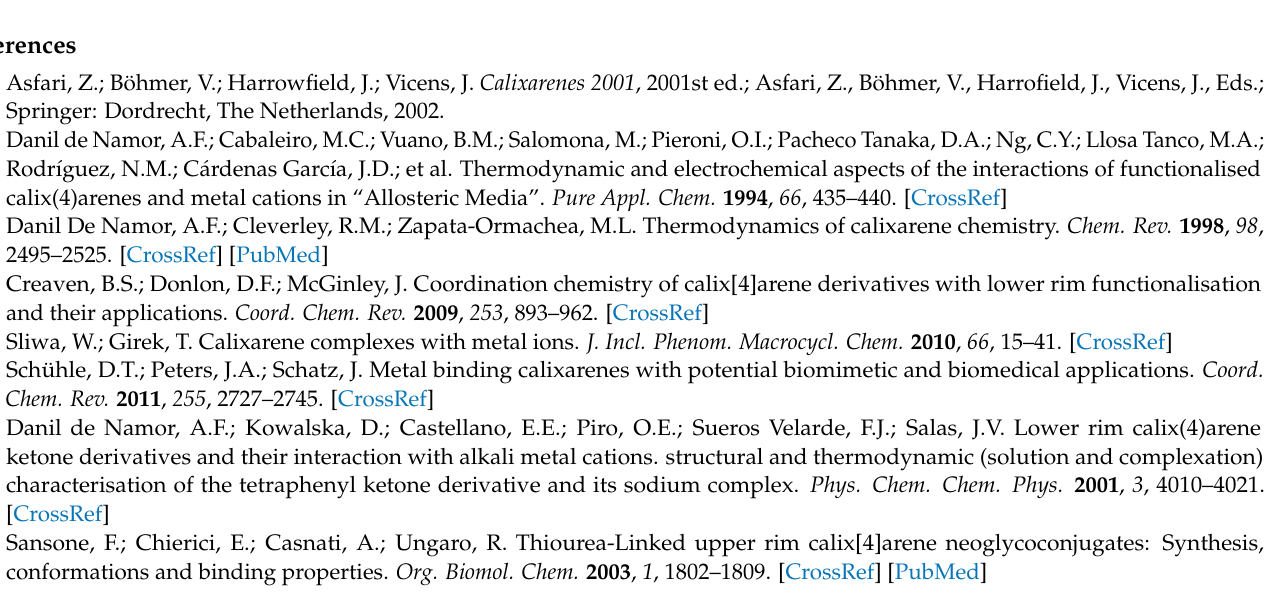
Figure S55, Molecular dynamics simulations: graphical summation of the results obtained for alkali metal complexes with glycocalixarene l. Figure S56, Time-averaged percentage and number of cation- coordinating groups of l in MeOH and DMF obtained by MD simulations. Note: All experiments and MD simulations have been performed at 25 ◦